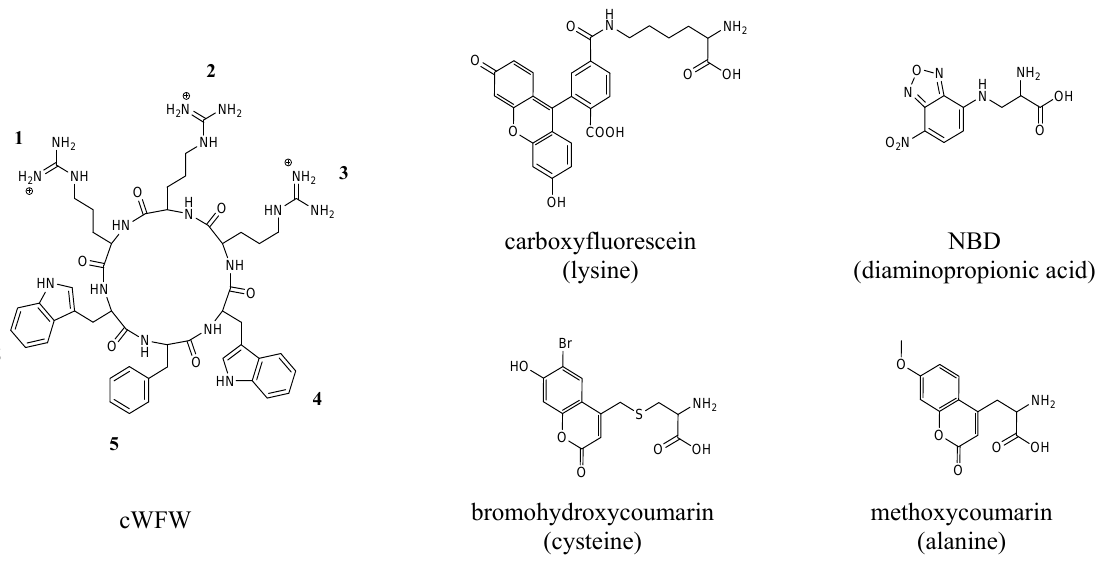
Figure 1. Chemical structures of cWFW and the four fluorescent labels used in this study. Fluorophores are depicted coupled to the respective amino acid (latter given in brackets) used to introduce the labels into the peptide